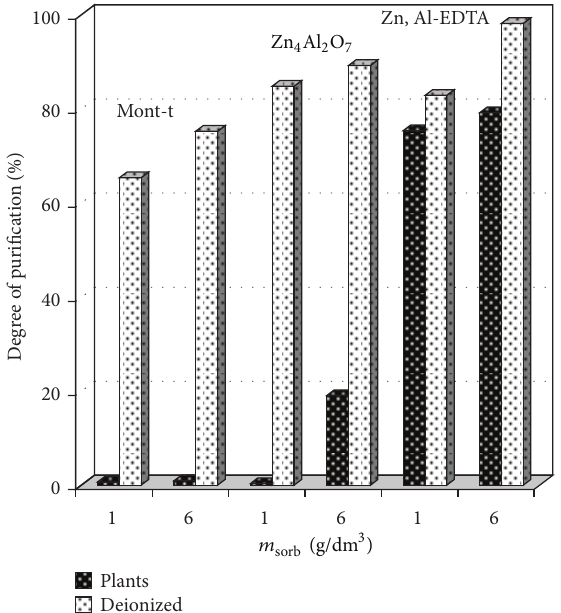
Figure 5: U(VI) sorption isotherms for chelate and carbonate forms of adsorbents. pH = 6.5 , 𝑉